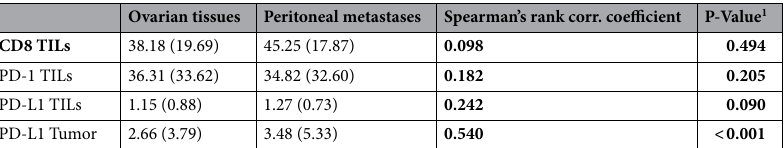
Table 2. Correlation between percentages of positive cells of PD-1 among TILs, PD-L1 among tumor cells and TILs, and CD8 positive cells among TILs in paired primary tissues and implants. Given are mean (SD), 1 According Spearman’s rank correlation.